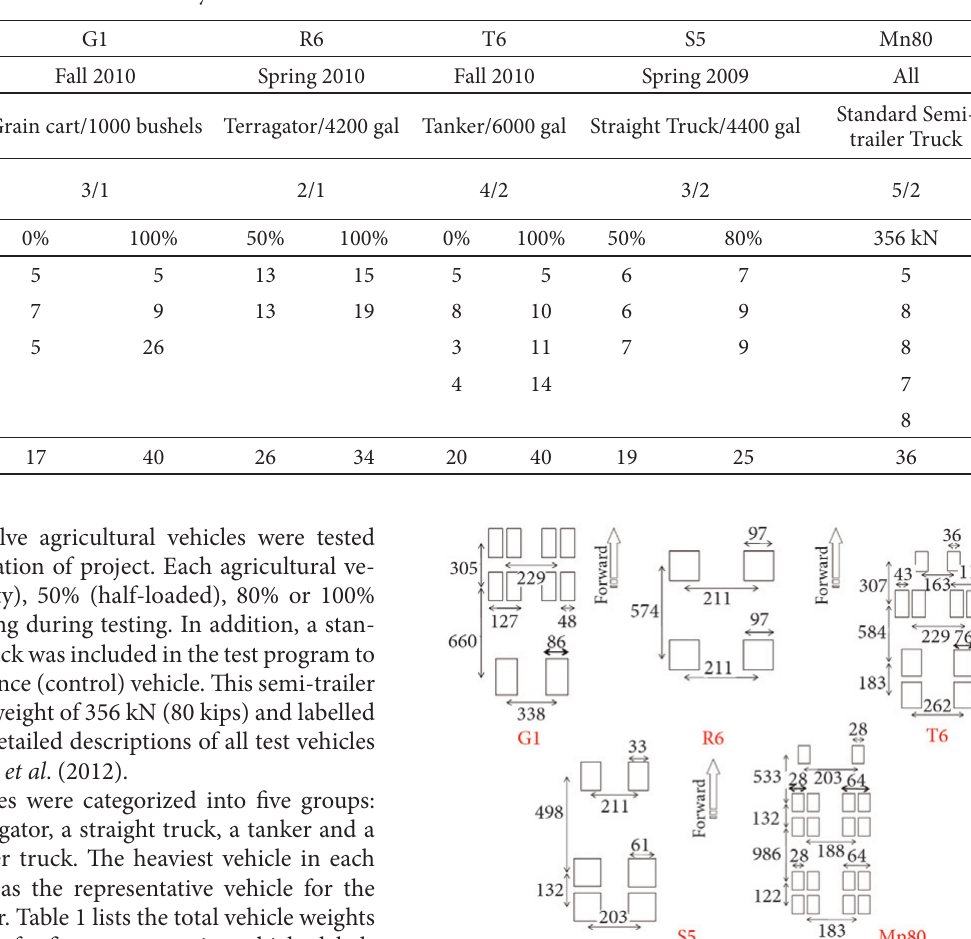
Table 1. Five representative test vehicles analysed